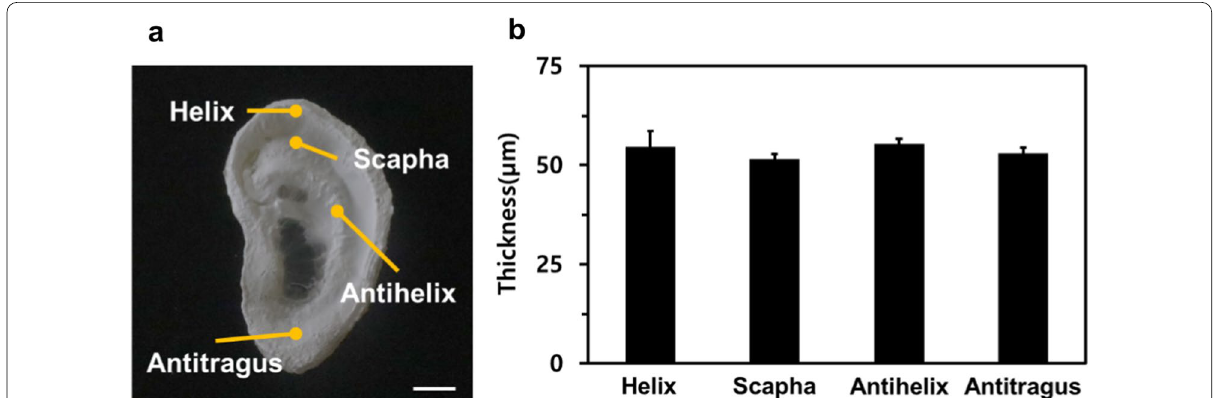
Fig. 6 a Conformally fabricated nanofiber mat on the 3D ear cartilage-shaped hydrogel collector. The scale bar is 1 cm. b The thicknesses of the electrospun nanofiber mat at several positions, including helix, scapha, antihelix, and antitragus on the flattened 3D ear cartilage-shaped hydrogel